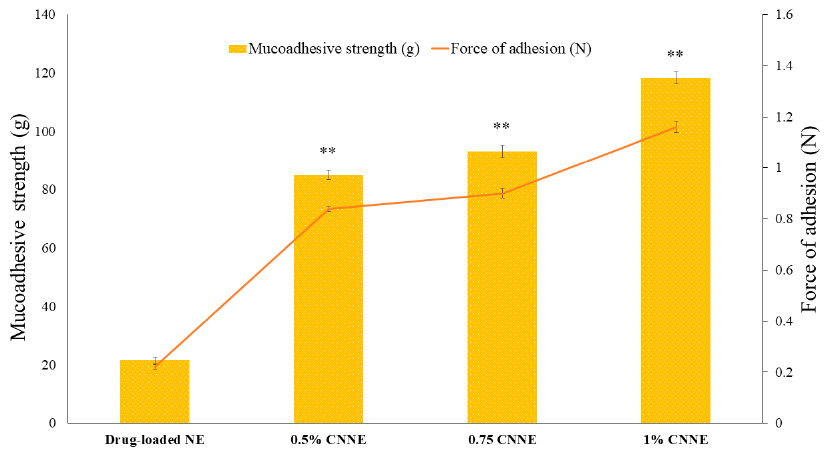
Figure 8. Mucoadhesion strength and force of adhesion of different nanoemulsions measured by the mucoadhesive strength test. Values are expressed as mean ± SD ( n = 3), where ** represents significant difference from blank nanoemulsion ( p < 0.01).